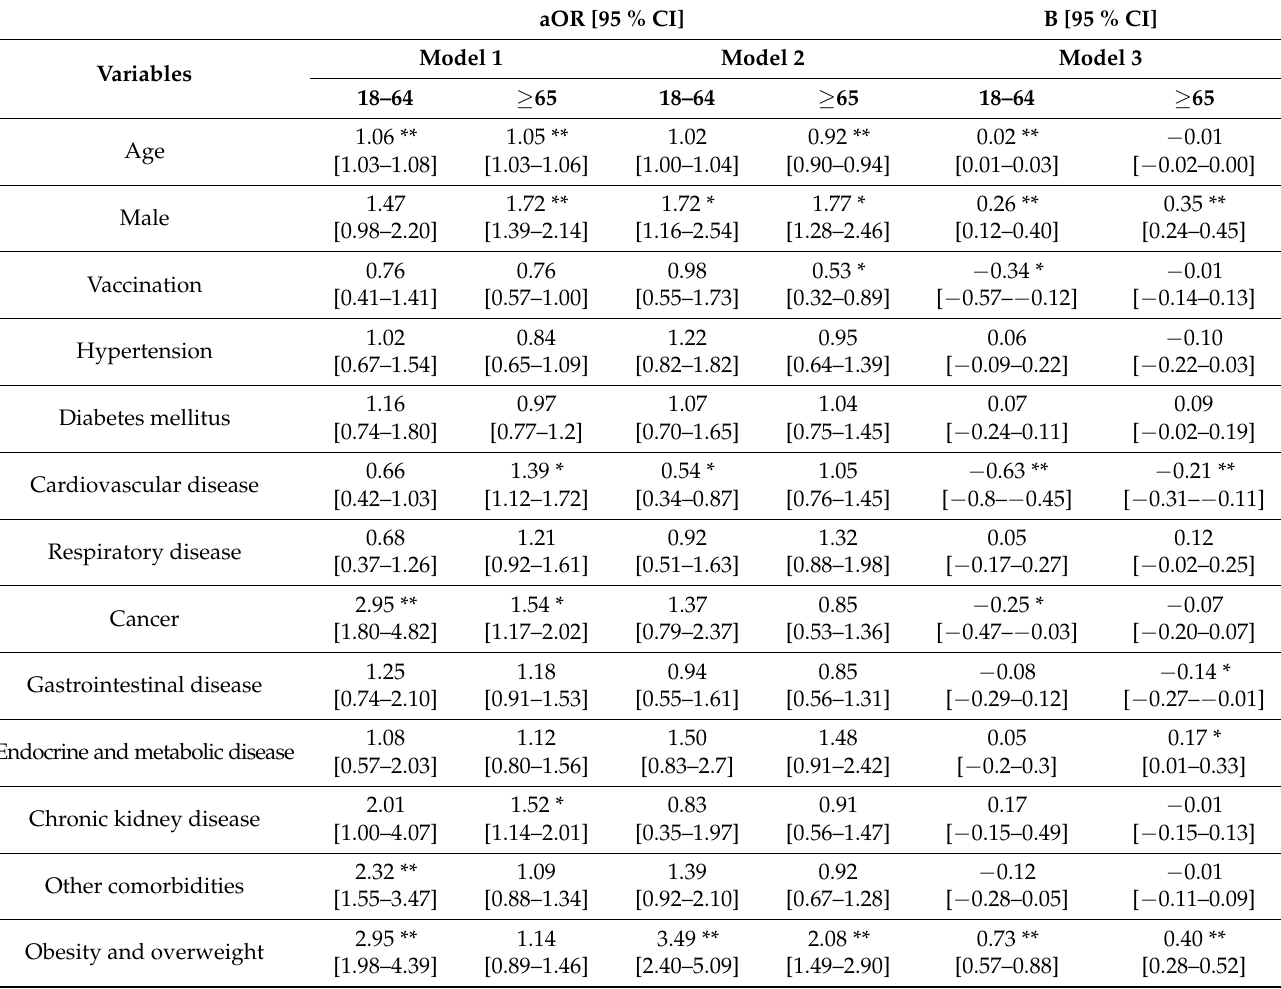
Table 2. Associations between age, sex, vaccination, comorbid diseases, obesity and death, need for ICU admission and severity score of SARS-CoV-2 in patient age groups under 65 years (Age Groups 1 and 2) and over 65 years (Groups 3 and